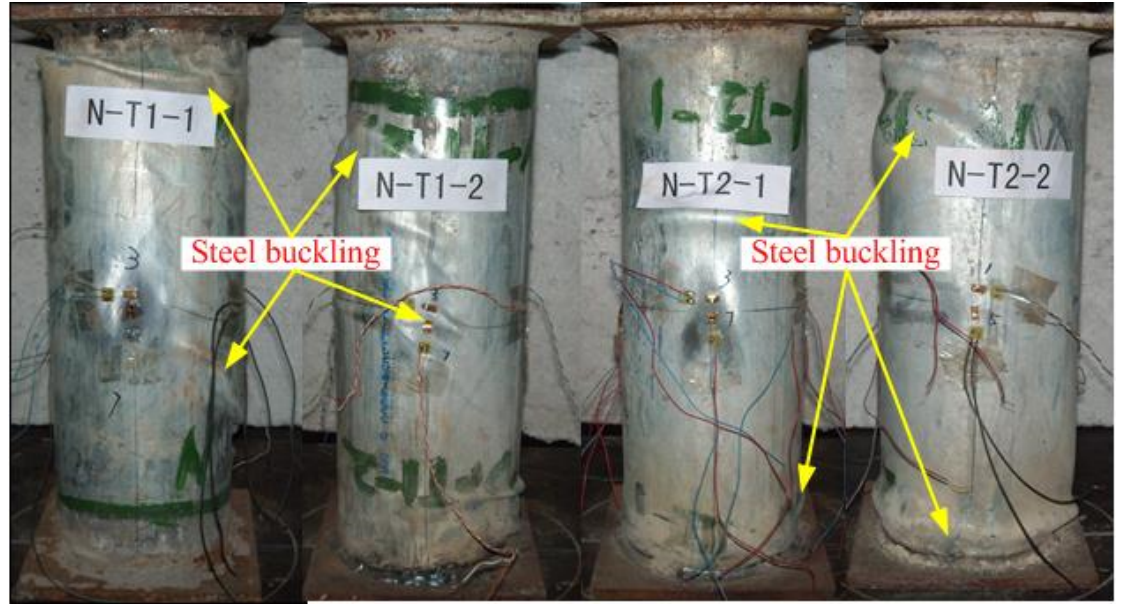
Figure 2. Failure mode characteristics of the SCCFTST columns.